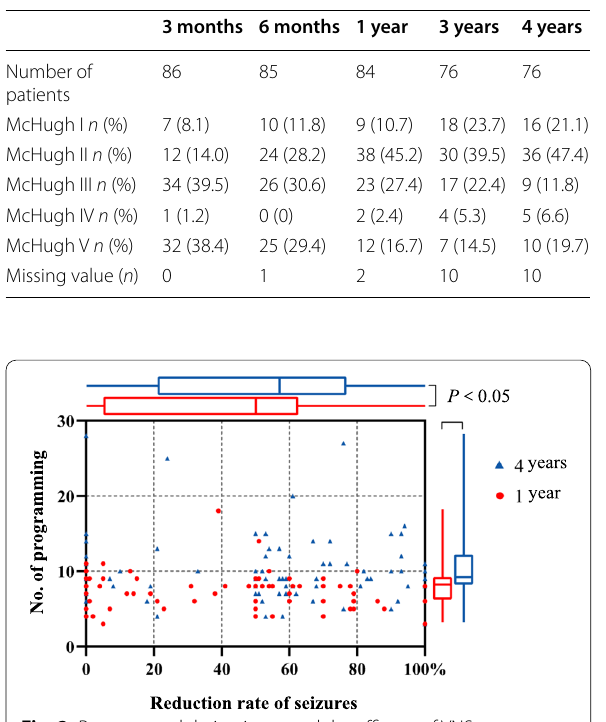
Table 2 The efficacy of VNS